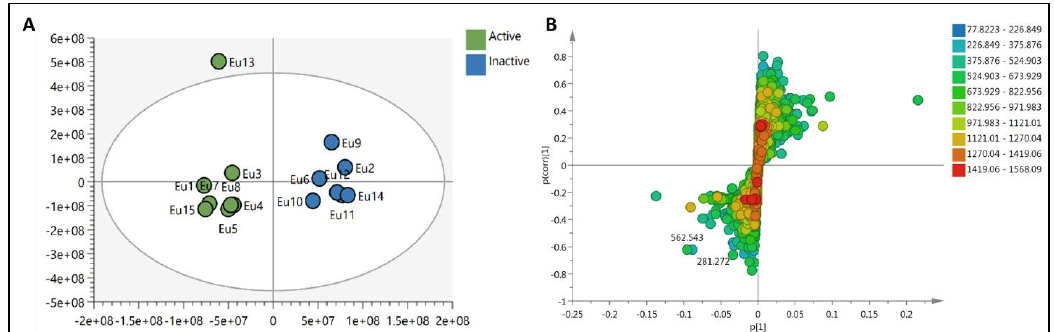
Figure 2. ( A ): PCA score plot for all crude extracts of the tested Euphorbia species, ( B ) : PCA loading plot showing the distinctive metabolites.